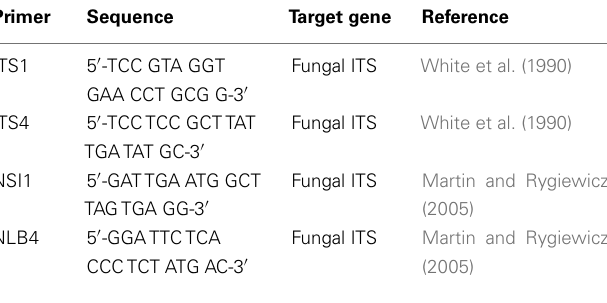
Table 2 | Primer sets used for ITS gene PCR amplification and